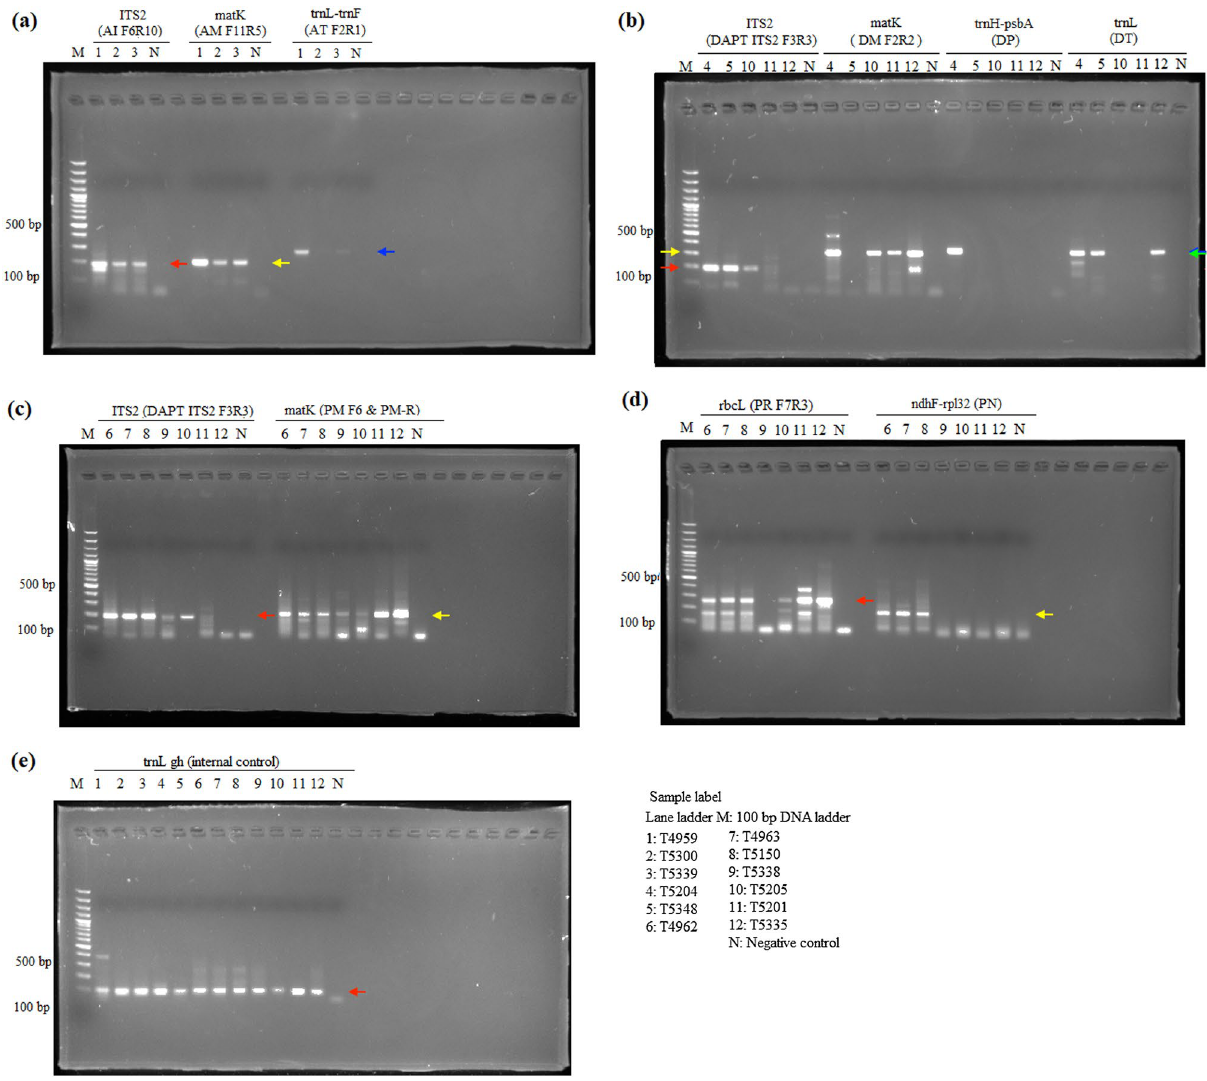
Figure 5. Gel electrophoresis of PCR amplification results of commercial wood product using CCDB method with ( a ) agarwood samples (red arrow—ITS2 at 181 bp, yellow arrow— matK at 209 bp, blue arrow— trnL - trnF at 280 bp); ( b ) rosewood samples (red arrow—ITS2 at 180 bp, yellow arrow— matK at 300 bp, blue arrow— trnH - psbA at 334 bp, green arrow— trnL at 314 bp); ( c ) rosewood samples (red arrow—ITS2 at 180 bp, yellow arrow— matK at 200 bp); ( d ) rosewood samples (red arrow— rbcL at 259 bp, yellow arrow— ndhF - rpl32 at 167–173 bp); ( e ) all 10 commercial samples amplified with internal control primers (red arrow—internal control